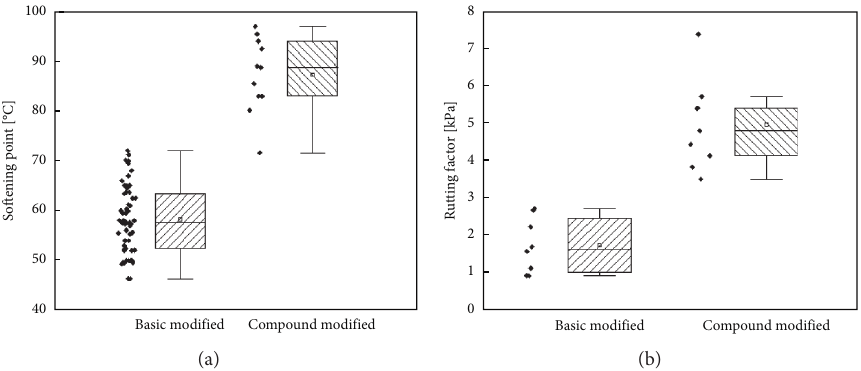
Figure 5: Softening point and rutting factor of high modulus asphalt: (a) softening point; (b) rutting factor.